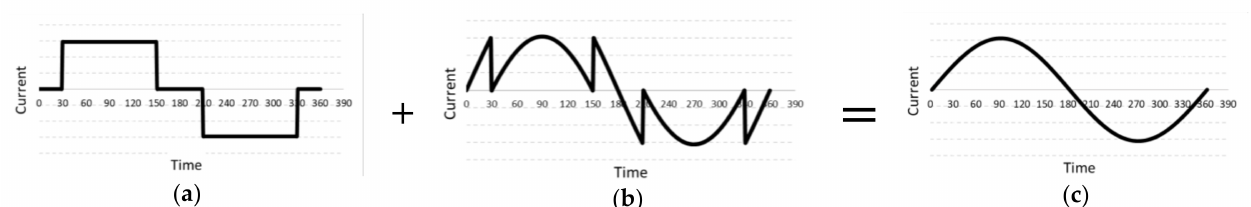
Figure 12. Current waveforms in phase a of the HTR. ( a ) Input current in rectifier 1. ( b ) Input current in rectifier 2. ( c ) Input current (sinusoidal) in the HTR.